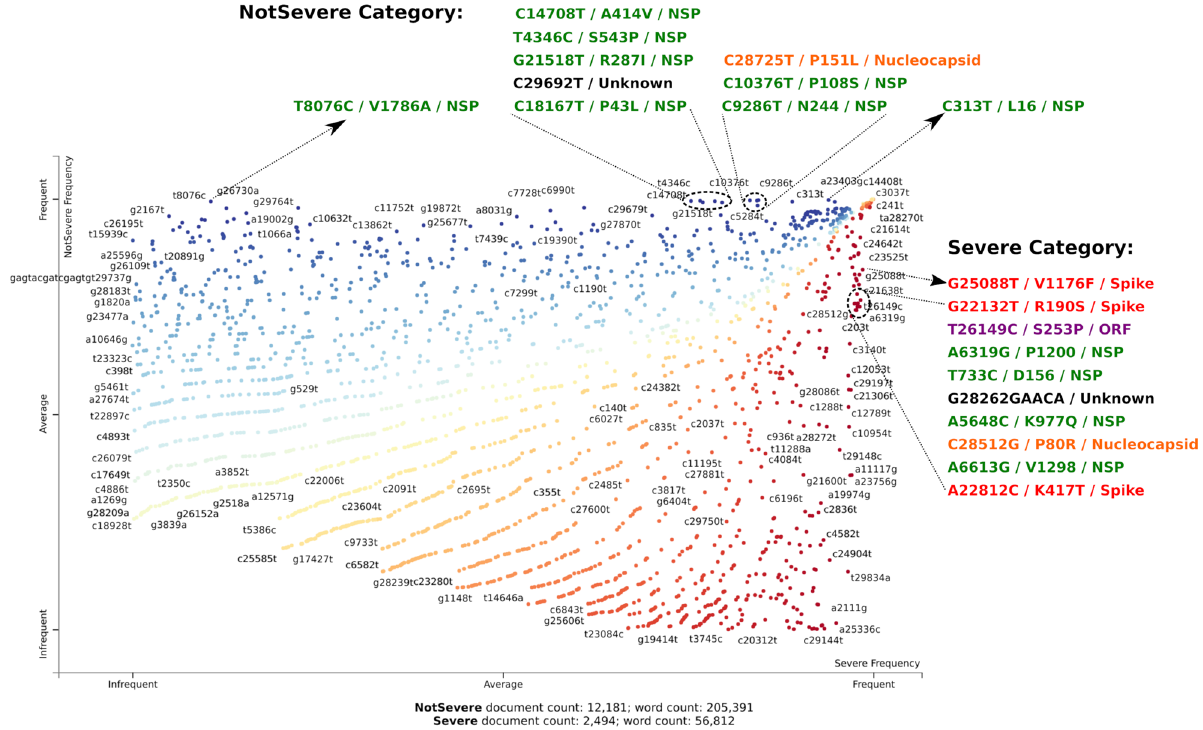
Figure 4. Visualising infection severity association of mutations. The figure shows the distribution of SARS- CoV-2 mutations in corpus along ’Severe’ or ’NotSevere’ frequency gradient in X and Y-axis, respectively. Points highlight mutations and are coloured according to binary classification based on F-scaled scores (see methods under Severity classification of Patient Health Status). Note that nucleotide mutations coloured in black (as Unknown) are on